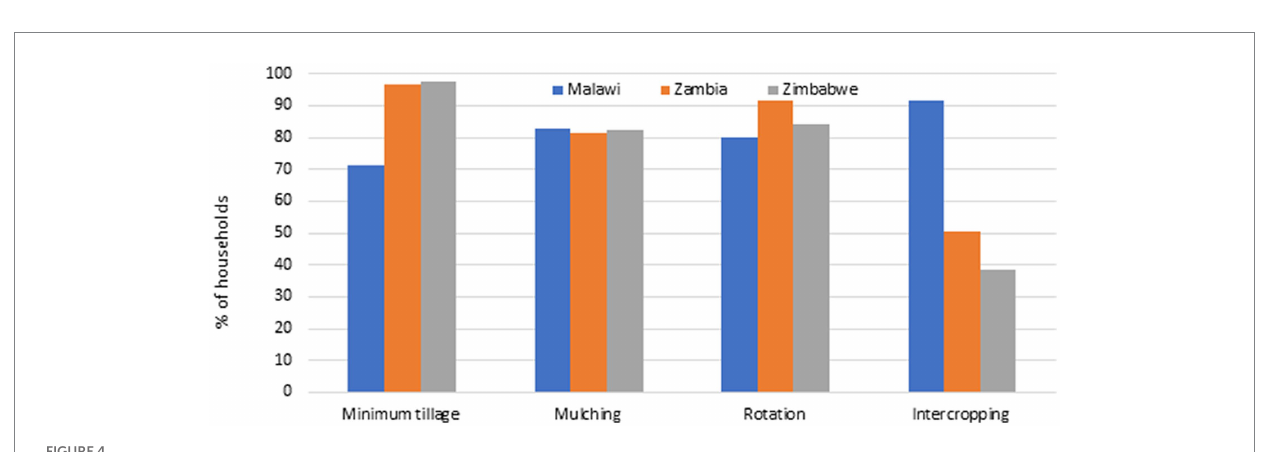
FIGURE 4 Awareness of CA practices by country (% of